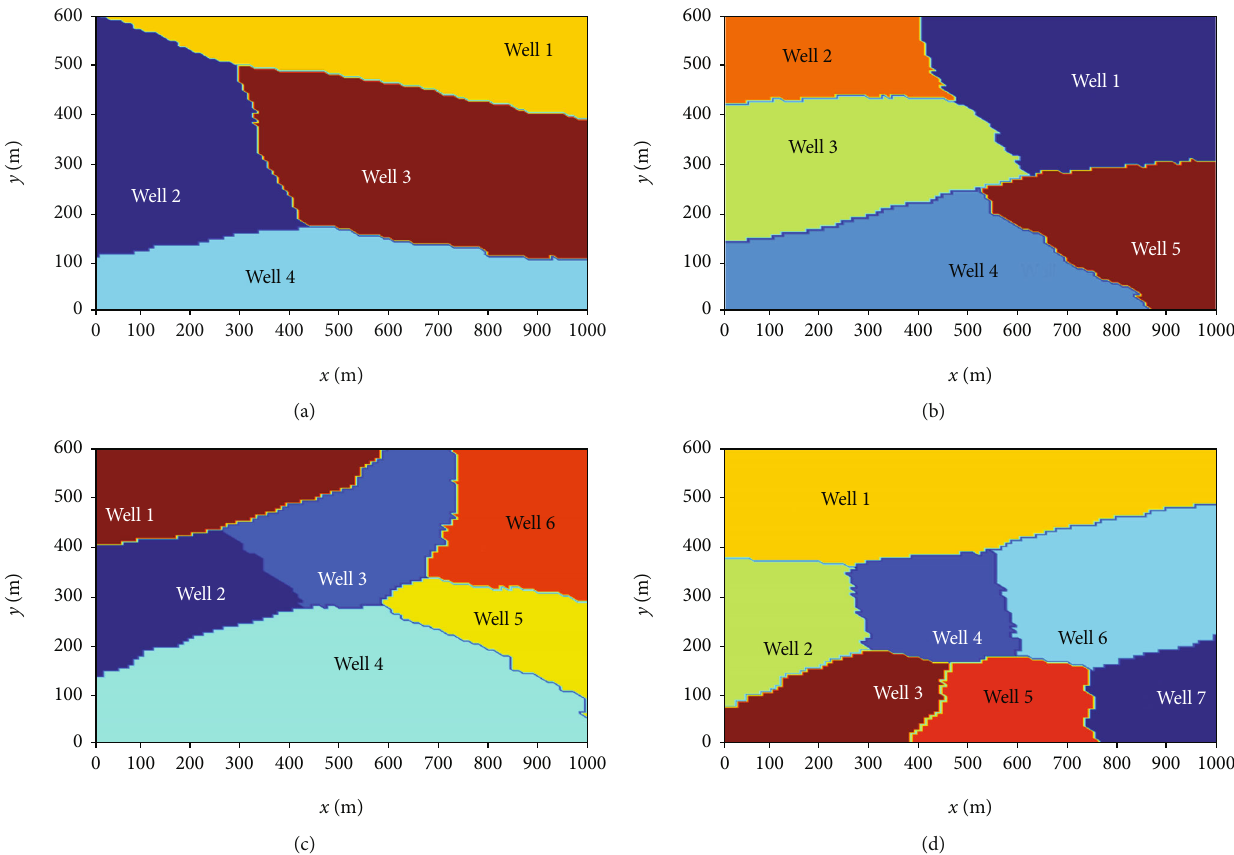
Figure 16: Geometries of the control volumes: (a) 4 production wells, (b) 5 production wells, (c) 6 production wells, and (d) 7 production